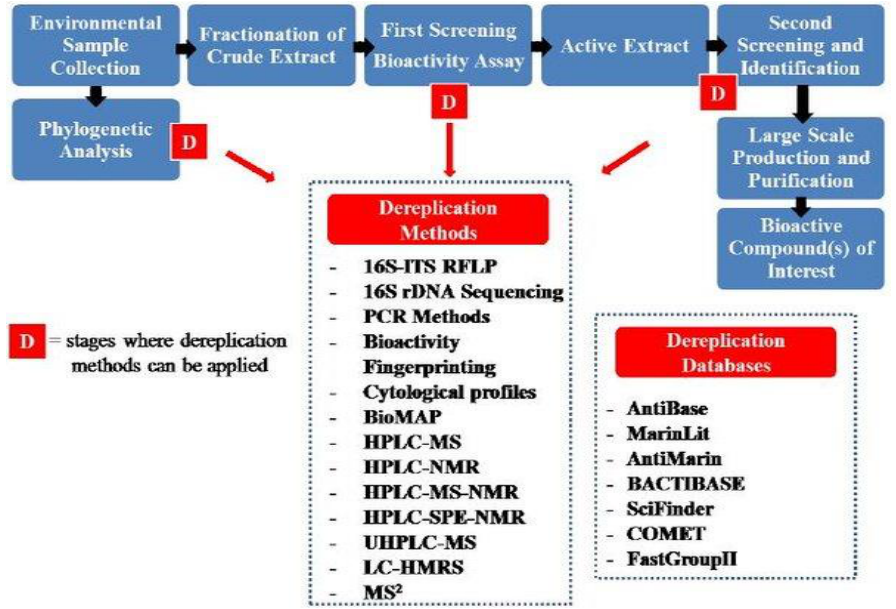
Figure 4. The various steps and techniques required during the characterization of plant products.